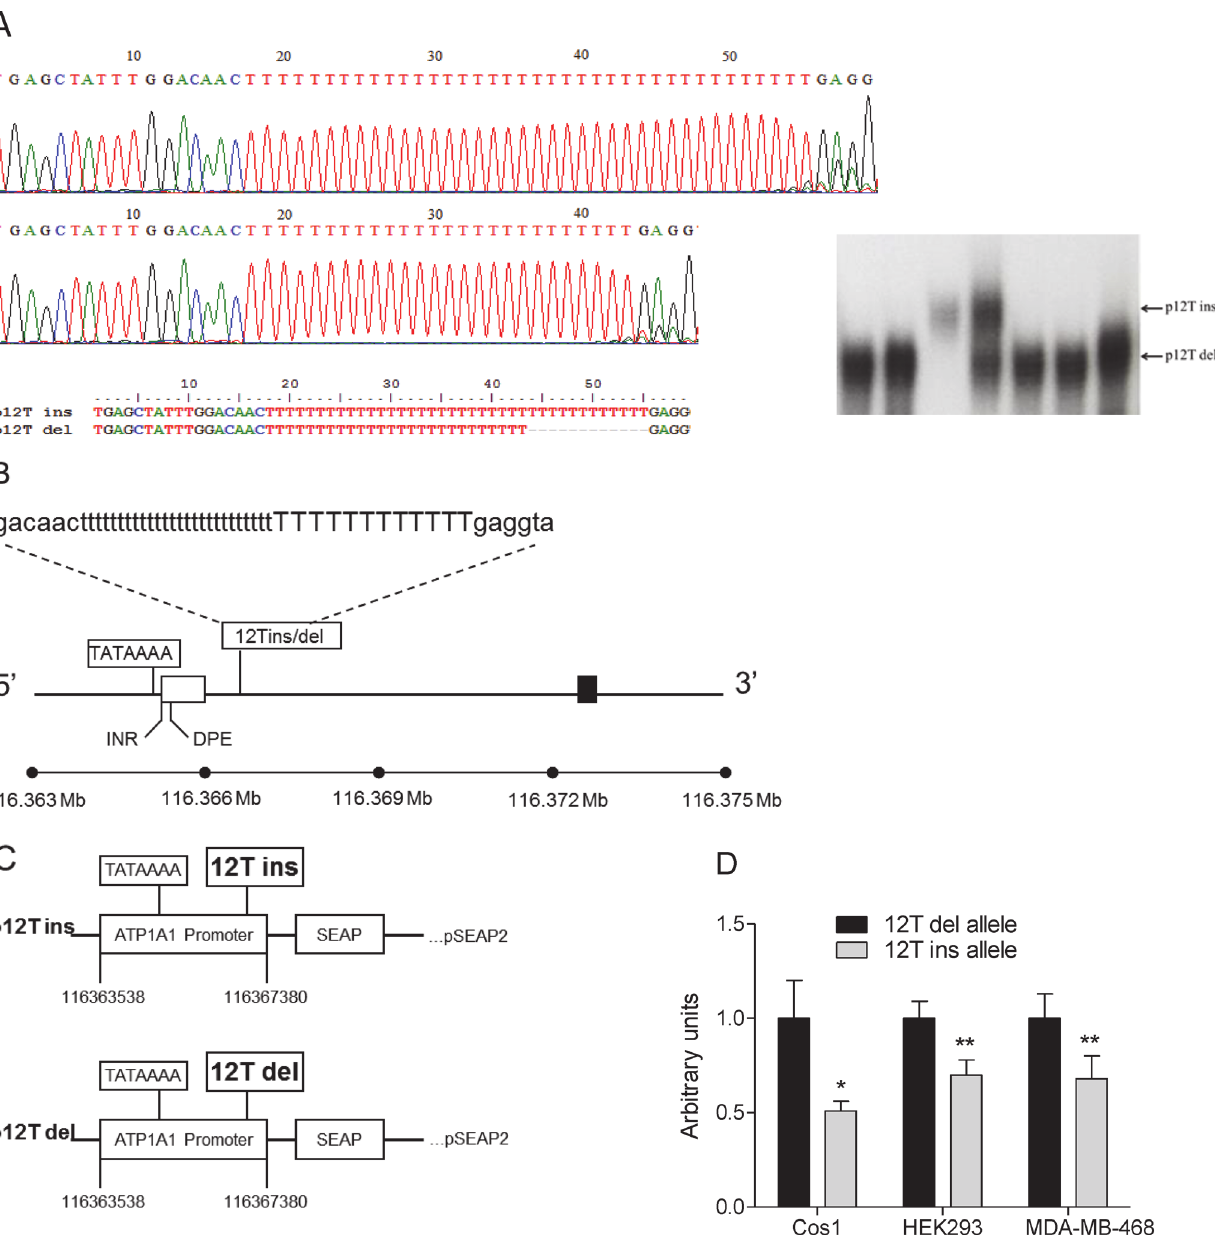
Figure 1. Identification of the 12T-ins/del polymorphism in the ATP1A1 promoter region and transcriptional activity of ATP1A1 promoter variants. (A) Nucleotide sequence spanning the poly-T sequence involved in the 12T-ins/del polymorphism from the two ATP1A1 (p12T ins, p12T del) reporter gene constructs utilized in the transcriptional assays. On right detection of 12T-insertion and 12T-deletion alleles by PCR-amplification followed by denaturing polyacrylamide gel (6%) electrophoresis used for genotyping of the Sardinian cohort. (B) Illustration of the ATP1A1 promoter region. Non-coding exon is presented as open box and exon encoding the NH 2 -terminal region is presented as black box. Sequence and location of the ATP1A1 12T-ins/del polymorphism is shown. The positions of TATAAA box, INR (initiator) and DPE (downstream promoter element) core promoter elements within ATP1A1 promoter are shown. Core promoter elements were identified based on 100% homology with corresponding consensus sequences [39,40]. (C) Schematic of two ATP1A1 (p12T ins, p12T del) reporter gene constructs. (D) Relative transcriptional activity of 12T-insertion (p12T ins) and 12T-deletion (p12T del) gene constructs in Cos1, HEK293 and MDA-MB-468 cells. * , P < 0.05; ** , P < 0.01 (two-tailed student t